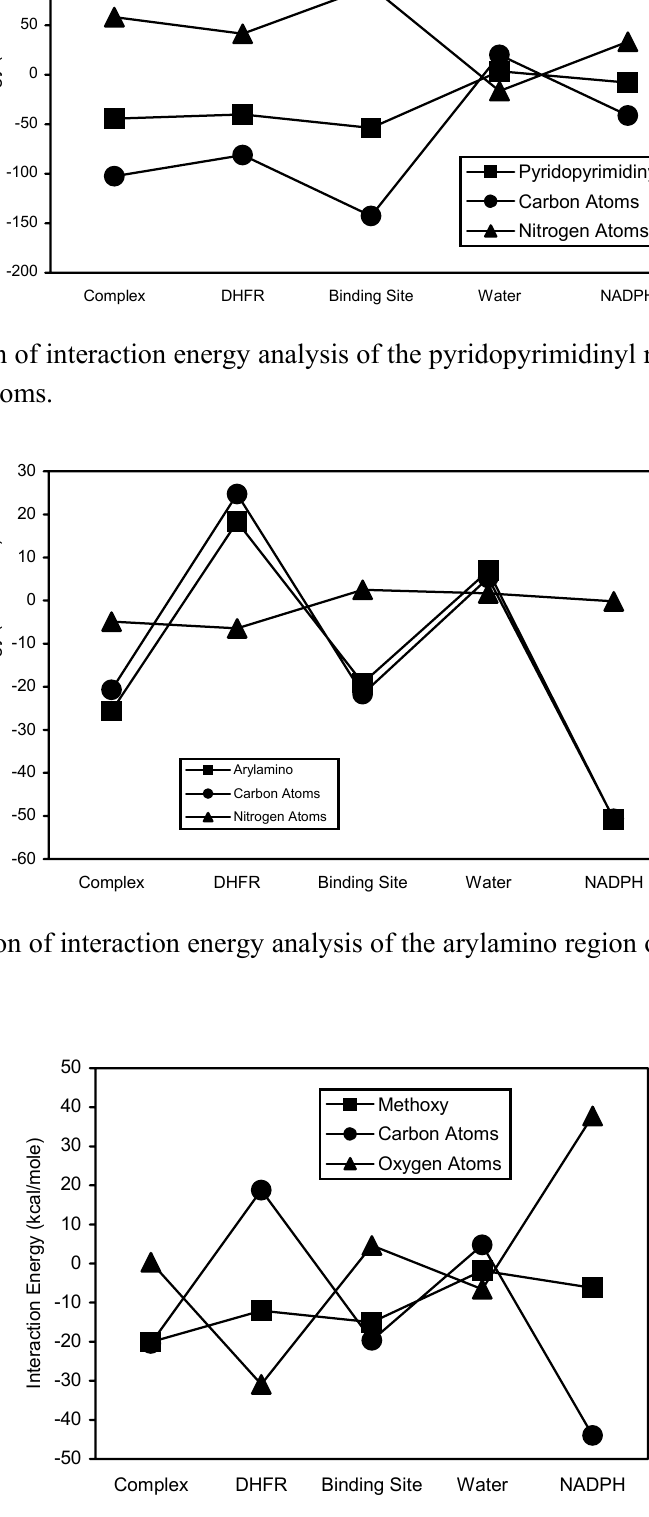
Figure 11. Comparison of interaction energy analysis of the methoxy regions of TMQ with its carbon and oxygen